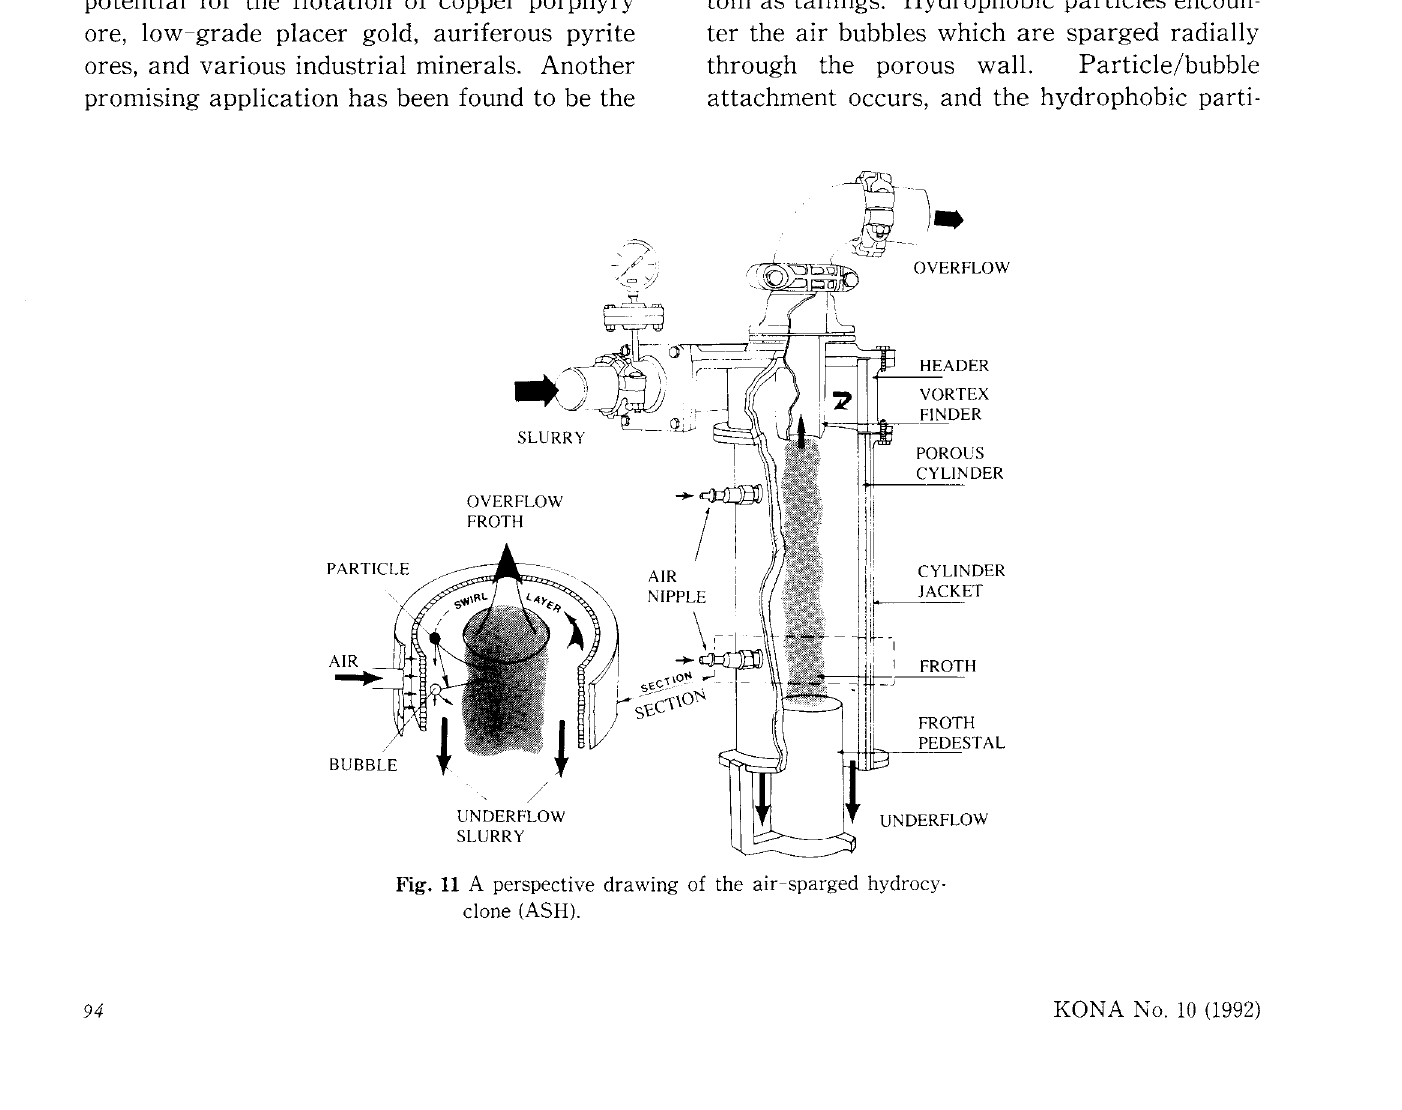
Fig. 10 A comparison of the coal-washability curve con structed using CT techniques with the coal-wa shability curve obtained by the traditional sink-float method.